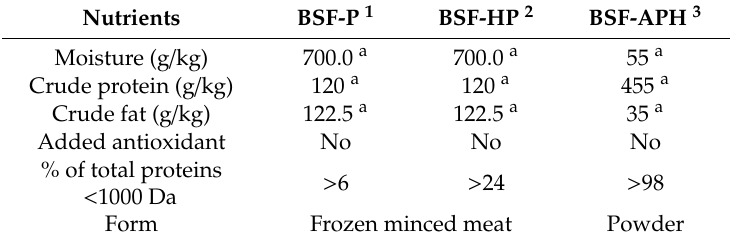
Table 2. Chemical composition of black soldier fly larvae (BSF) protein derivatives (as in basis, provided by